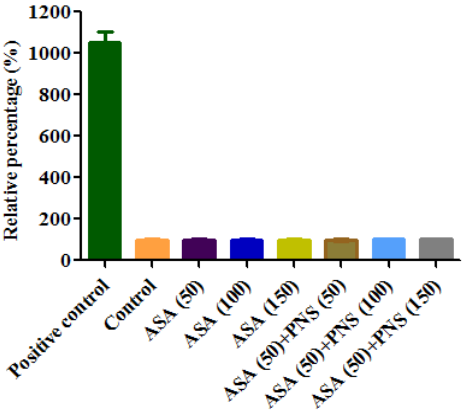
Figure 3. The cell membrane integrity of aspirin (ASA) or its combination with Panax notoginseng saponins (PNS) as detected by lactate dehydrogenase release assay. Compared with the control (untreated by drugs), ASA (50 – 150 μg/mL) had no considerable effect on integrity of cell membrane, and similar results were found in the combinations of ASA (50 μg/mL) and PNS (50 – 150 μg/mL). Data were presented as mean ± SD ( n = 3).